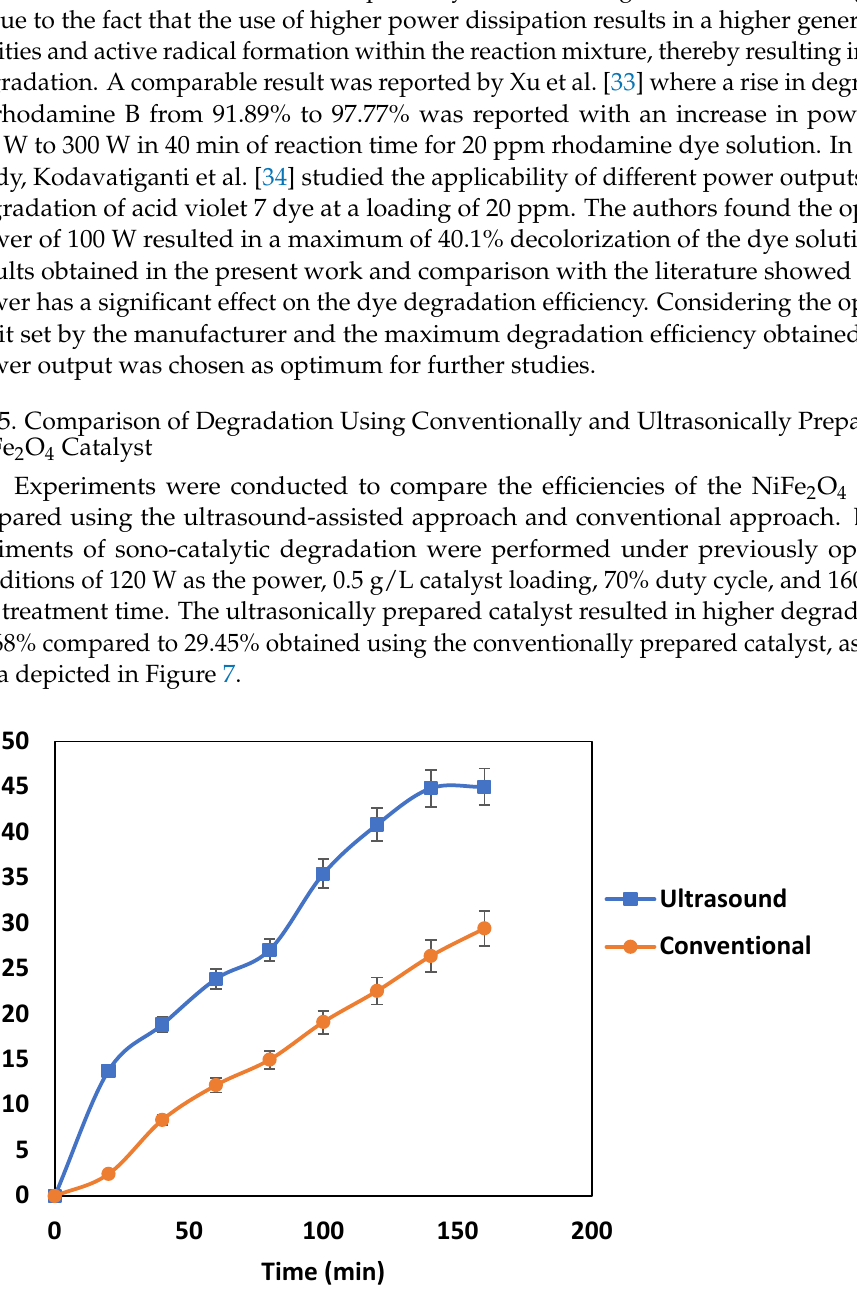
Figure 7. Comparison of ultrasonically synthesized and conventionally synthesized catalyst applied for the degradation of Chrysoidine R dye.